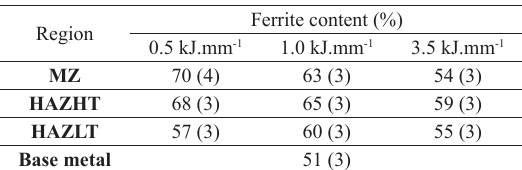
Table 2. Ferrite content of welded joints with 0.5 kJ.mm -1 , 1.0 kJ.mm -1 and 3.5 kJ.mm -1 in the different regions analysed: molten zone (MZ);